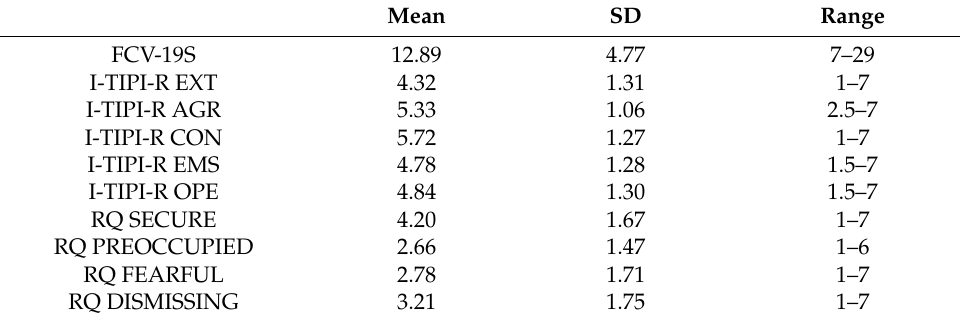
Table 1. Psychometric scores for the entire sample ( n =